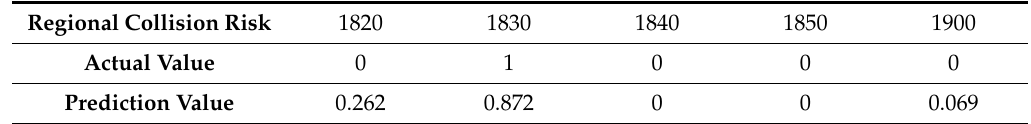
Figure 19. 05-Jan-2014 Regional collision risk. Table 9. 05-Jan-14 Regional Collision Risk.